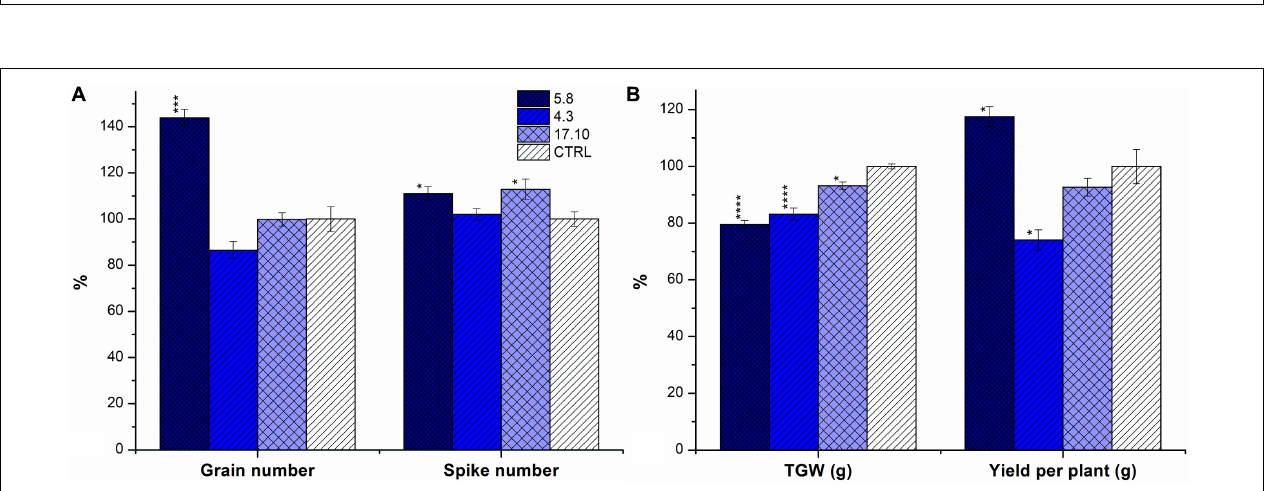
FIGURE 7 | Yield parameters of KD-CKX1 lines grown in a greenhouse. Grain and spike number (A) ; yield per plant and TGW (B) was calculated in KD-CKX1 lines (5.8, 4.3, and 17.10) and control plants grown in the control greenhouse conditions (photoperiod of 24 ◦ C/16 h/light and 22 ◦ C/8 h/dark) during years 2014–2015. Data are expressed as percentage (%) of the value obtained for CTRL, which was set up to 100%. Values are mean ± SE ( n = 25). A non-parametric Kruskal–Wallis Anova & Median test analysis was performed followed by a post hoc multiple comparison of mean rank (Statistica v. 13.3); ∗ p < 0.01, ∗∗ p < 0.001, ∗∗∗ p < 0.0001, ∗∗∗∗ p <